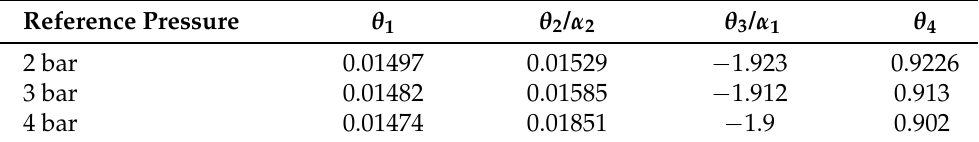
Table 1. Parameters for the linear system identified under different target